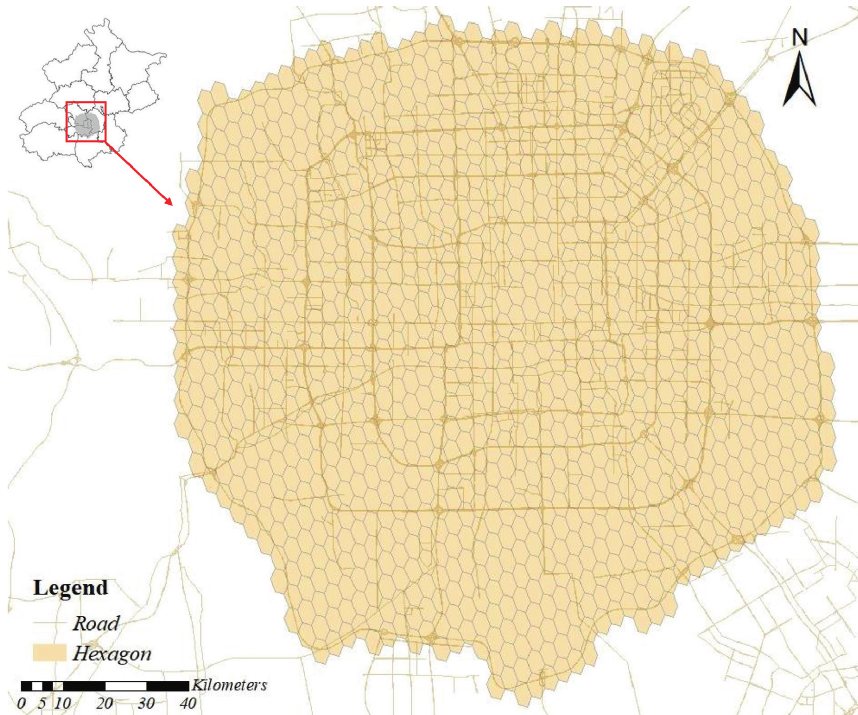
Figure 2: Hexagon grids and the study area. The main map shows the arterial road and how the study area is divided into hexagons. The submap is the location of the study area in